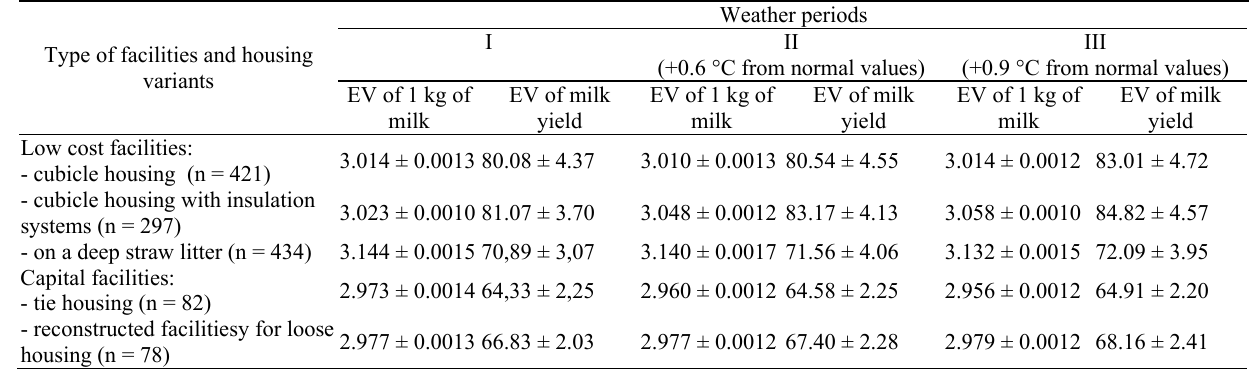
The average energy value (EV) of 1 kg of milk and milk yield/head in winter period, MJ